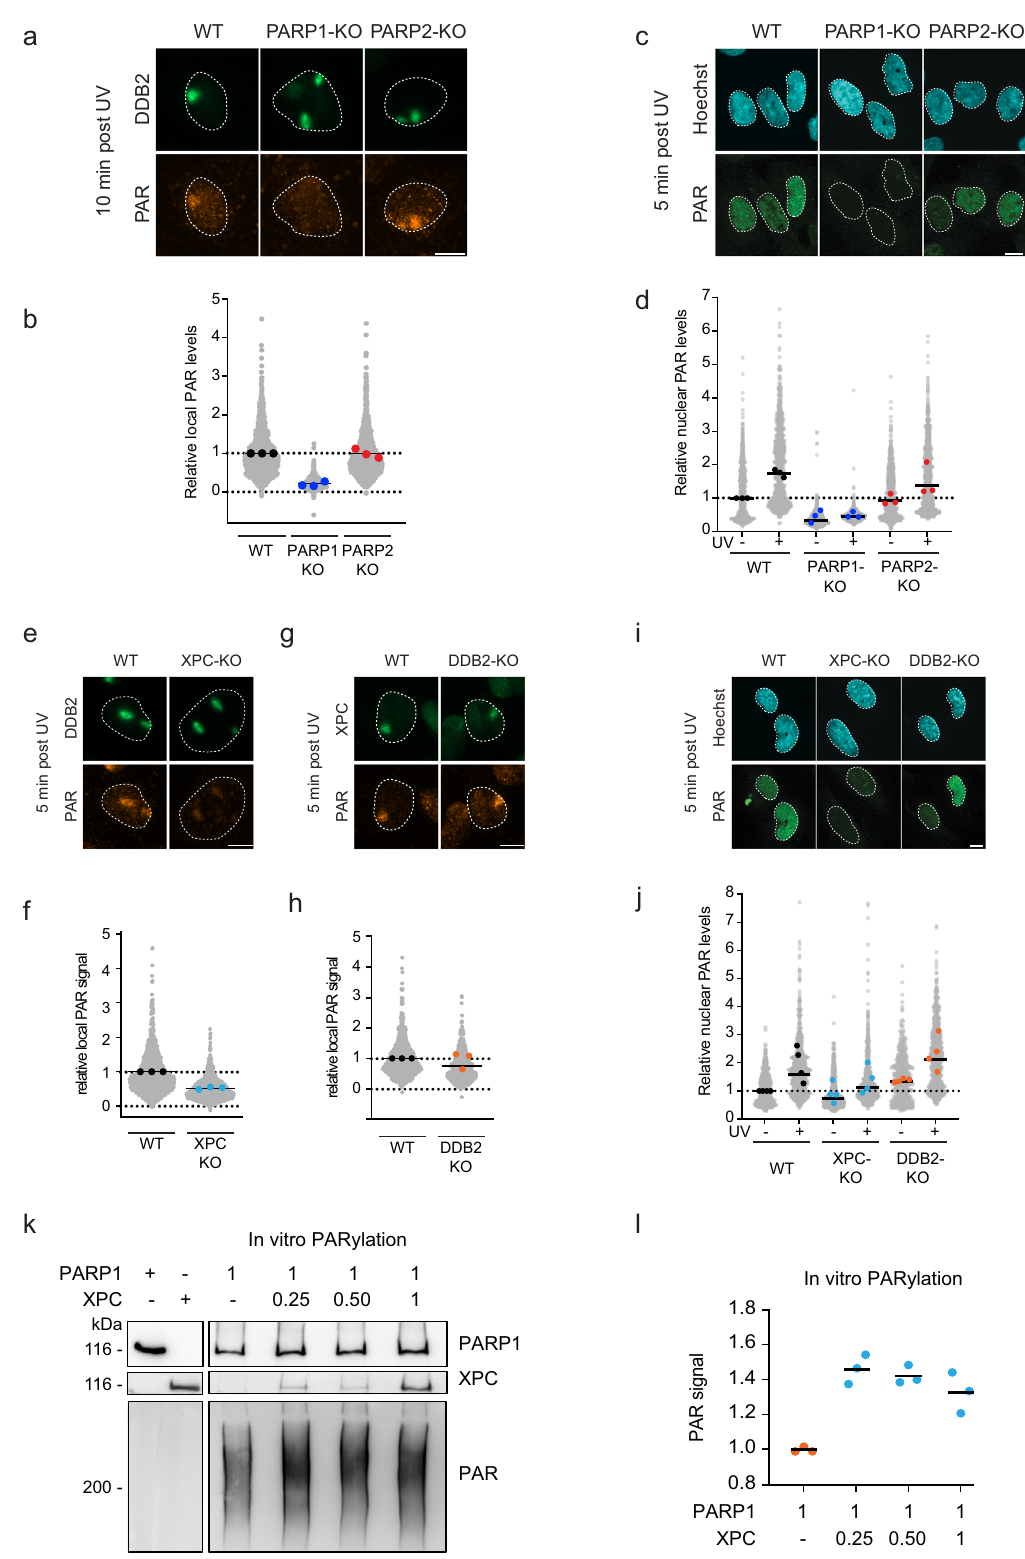
XPC stimulates the poly-(ADP-ribose) response to UV lesions . in PARP1-KO and PARP2-KO cells (Fig. 4a, b). PARylation strongly increased at sites of local UV irradiation, marked by The PARP response involves the rapid and robust DNA damage- DDB2 recruitment, in WT cells and PARP2-KO cells, but not in induced PARylation mainly of PARP1 itself, but also of other PARP1-KO cells (Figs. 4a, b; Supplementary Fig. 2a). Similarly, chromatin substrates 40 . To better understand how the PARP nuclear PAR levels also increased after global UV irradiation in a response modulates GGR, we measured nuclear PAR levels at manner that was dependent on PARP1, but not on PARP2 sites of local UV-induced DNA damage by immuno fl uorescence NATURE COMMUNICATIONS| (2022) 13:4762